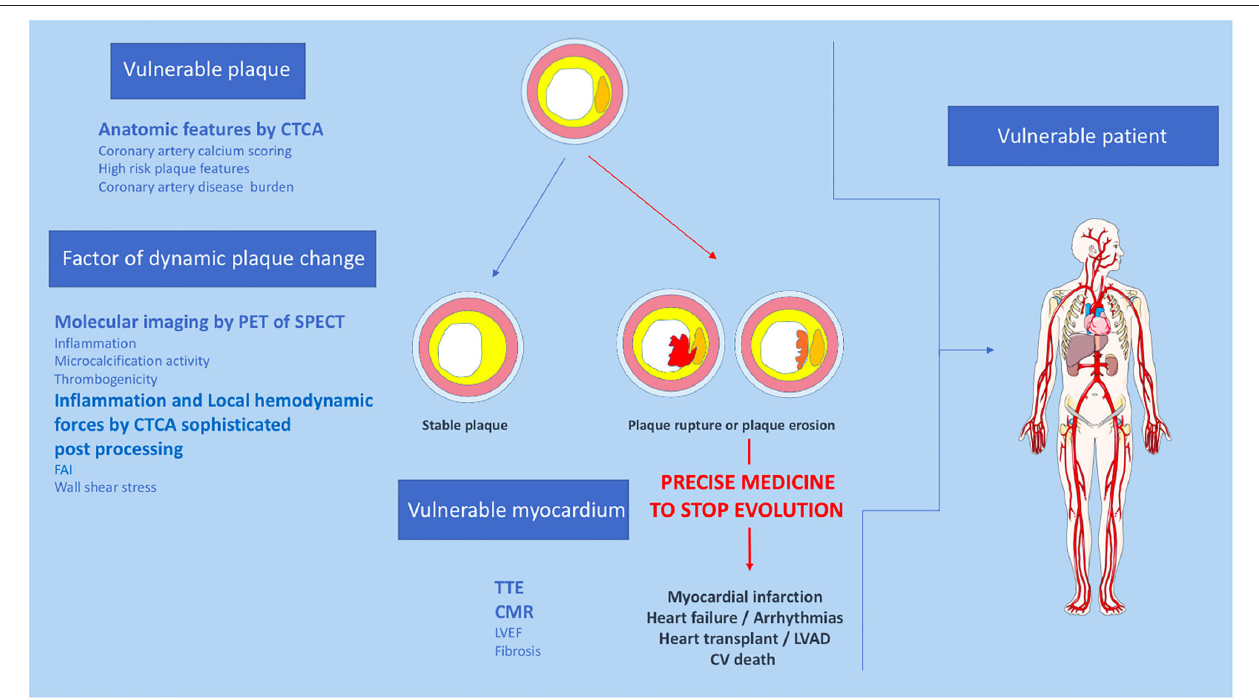
FIGURE 2 | Proposition of non-invasive multimodality imaging strategy to detect and treat coronary vulnerable patient. CTCA, Computed tomography coronary angiography; CV, cardiovascular; CMR, cardiac magnetic resonance imaging, FAI, fat attenuation index; LVEF, left ventricular ejection fraction; PET, positron emission tomography; SPECT, single photon emission computed tomography; TTE, trans thoracic